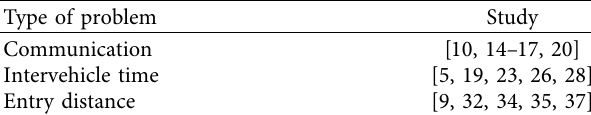
Table 5: Problem solved in primary study. Table 4: Selected primary